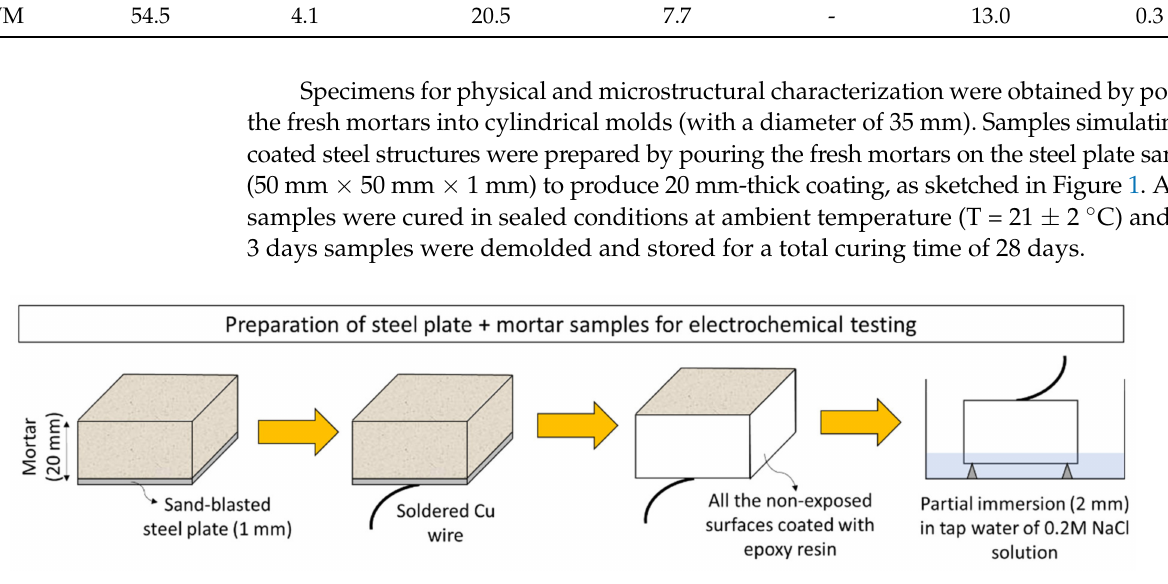
Figure 1. Schematization of the laboratory samples simulating the coated steel structure by 20-mm thick alkali activated mortar (normal weight fly ash-based mortars (M) and light weight alkali activated mortars (LWM)) layers. These samples were used for electrochemical